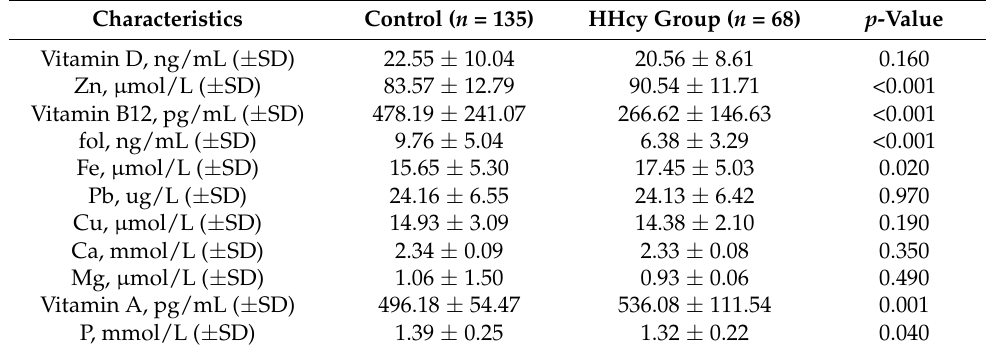
Table 3. Nutrient differences between the control and HHcy